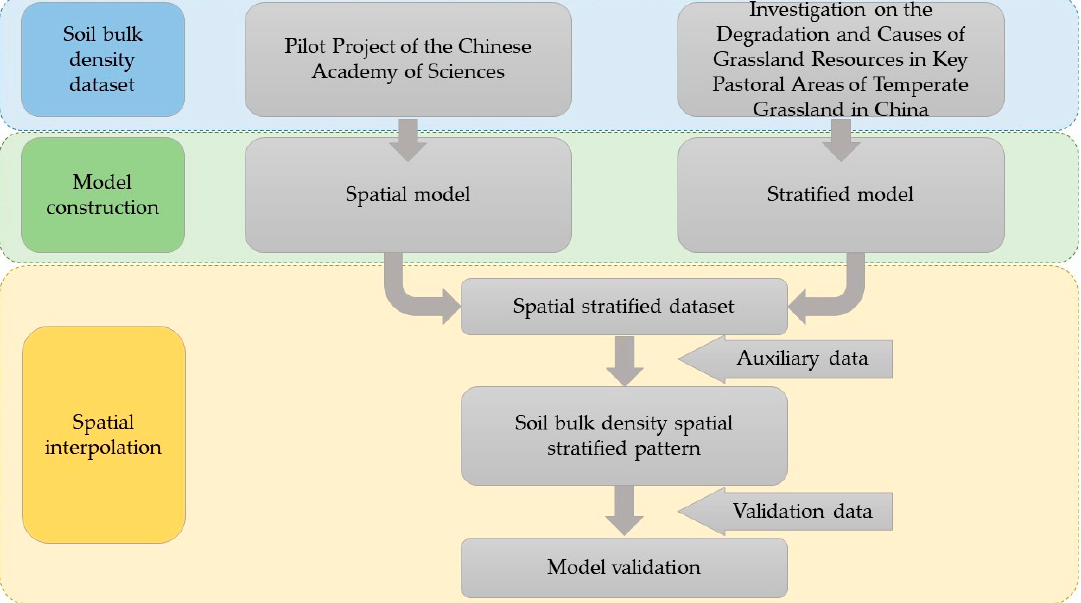
Figure 2. The flow chart of methodology.